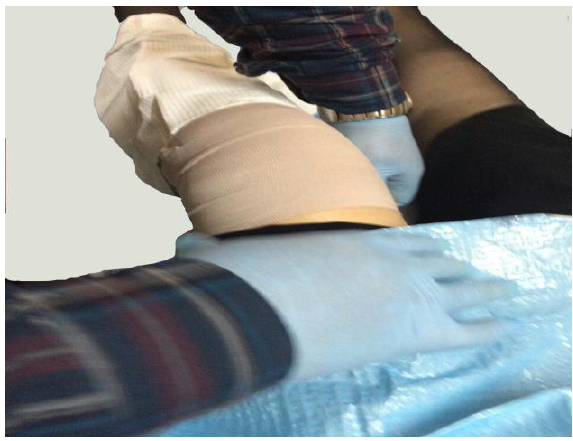
Figure 4. Injection of knee joint with HA.